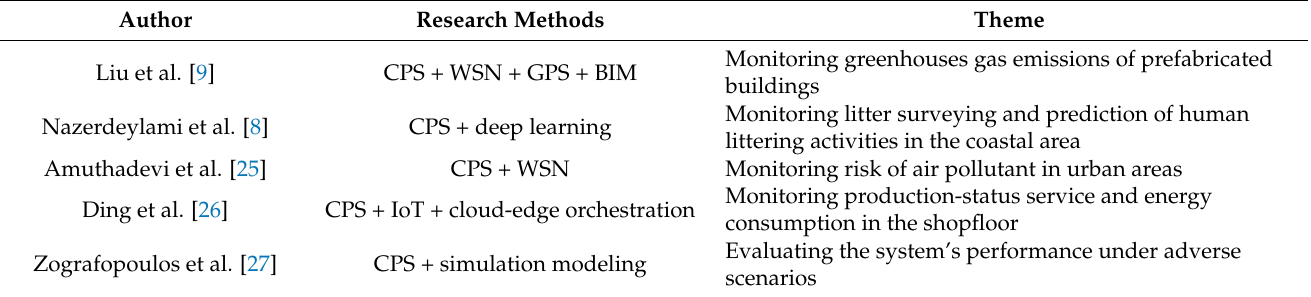
Table 1. The main existing methods and themes in